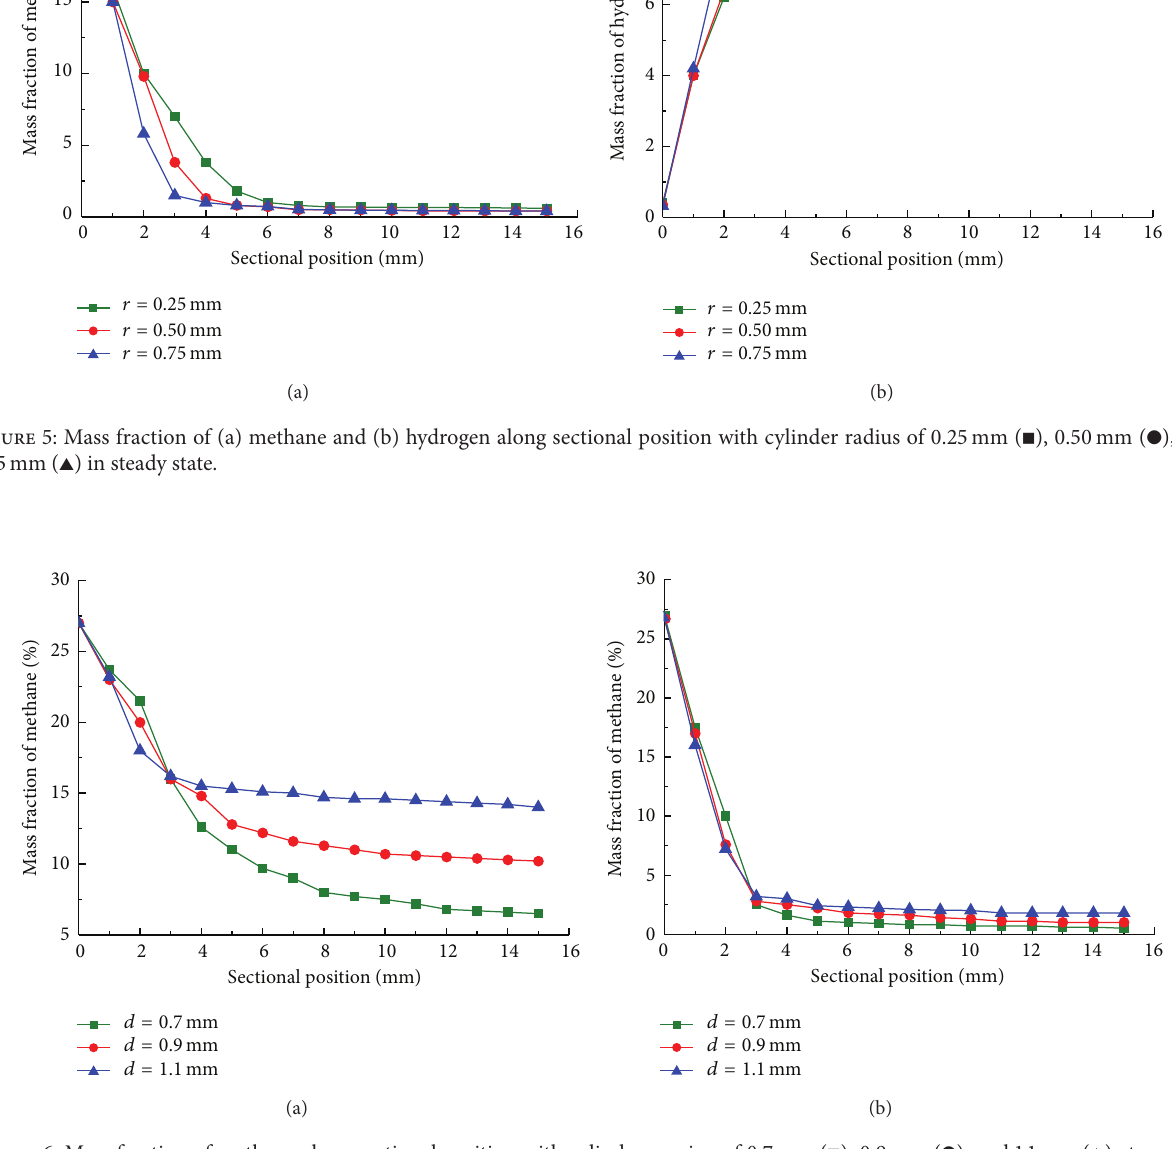
Figure 6: Mass fraction of methane along sectional position with cylinder spacing of 0.7 mm ( ◼ ), 0.9mm ( e ), and 1.1mm ( 󳵳 ) at reaction time of 5s (a) and 25 s (b).